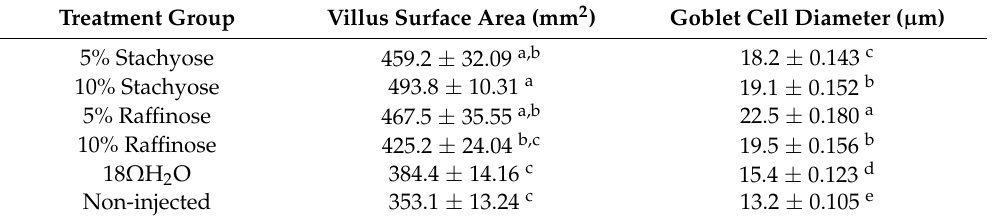
Table 2. Effect of intra-amniotic administration of experimental solutions on the duodenal small intestinal villus surface area (mm 2 ) and goblet cells diameter ( µ m). Values are means ± SEM, n = 6. a–e Treatment groups not indicated by the same letter are significantly different ( p < 0.05).